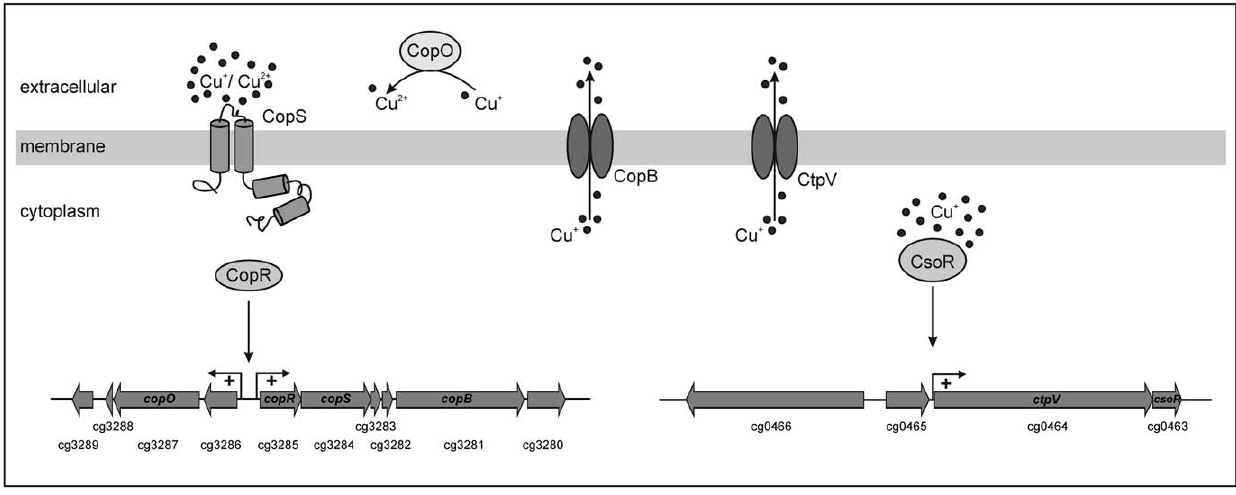
Figure 7. Model of copper excess response in C.glutamicum . The CopS sensor kinase recognises high extracellular copper concentrations followed by autophosphorylation and phosphotransfer to the response regulator CopR. Phosphorylated CopR binds to the direct repeat (TGAAGATTTnnTGAAGATTT) within the cg3286- copR intergenic region. This results in a transcriptional activation of both putative operons (cg3286- cg3289 and copR -cg3281) containing genes encoding copper resistance proteins, e.g. a putative multicopper oxidase (CopO) and a copper export ATPase (CopB). CopO can detoxify Cu + by converting it to the less toxic Cu 2 + and by binding free Cu ions. CopB is a cation ATPase and likely functions as a copper export pump. The Cu-specific regulator CsoR senses high intracellular copper concentrations and activates (or derepresses) the transcription of the copper export ATPase CtpV which is part of the copper detoxification process.